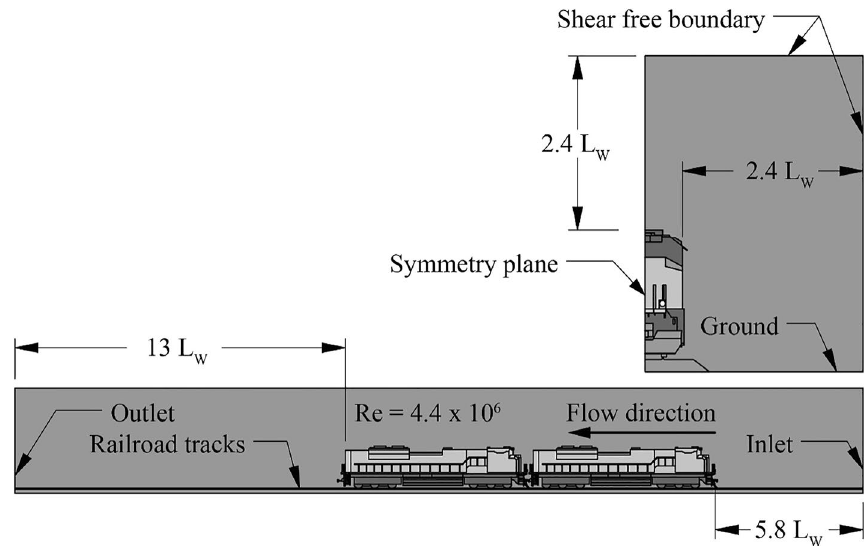
Fig. 4 Illustration of computational domain size and description of boundary